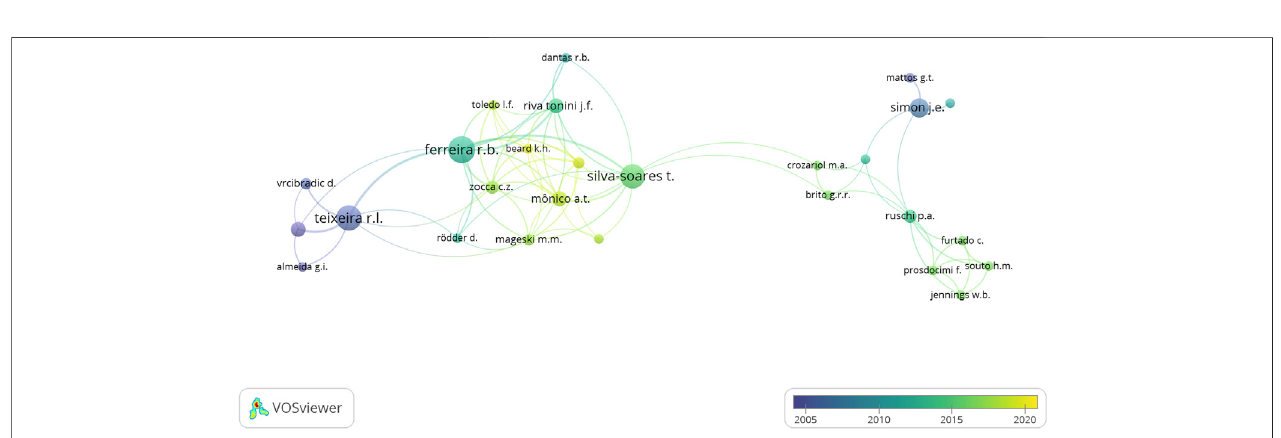
FIGURE 5 | Network of co-authors that make up the INMA ’ s collaborative identity of scienti fi c research and its incidences every fi ve years (1993 – 2019).